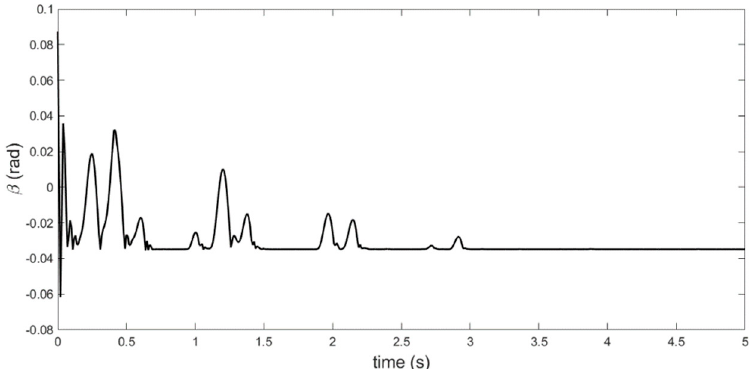
Figure 15. Time response of beta in lower speed of flutter (20 m/s).